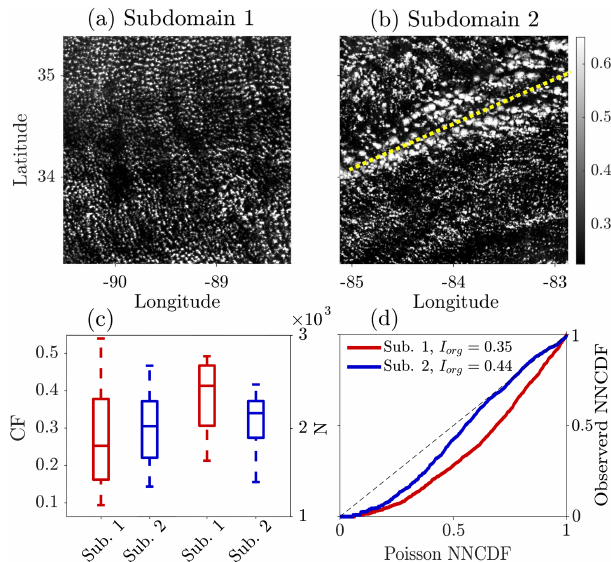
Figure 3. Snapshots of the two subdomains marked in Fig. 1c at 16:07EST (a) . Dashed yellow line in (b) shows the front of a GW. (c) Boxplots of the cloud fraction (CF) and the number of clouds (N) for subdomain-1 (red) and subdomain-2 (blue) between 15:02 and 18:02EST. (d) Observed NNCDF against Poisson NNCDF for the two subdomains (color specification follows the one in c ) at 16:07EST. Diagonal dashed line shows a randomly distributed cloud field, while deviations above (below) the diagonal indicate a tendency toward clustering (regularity). The organization index ( I org ; Tompkins and Semie, 2017) of each subdomain is given in the top-left